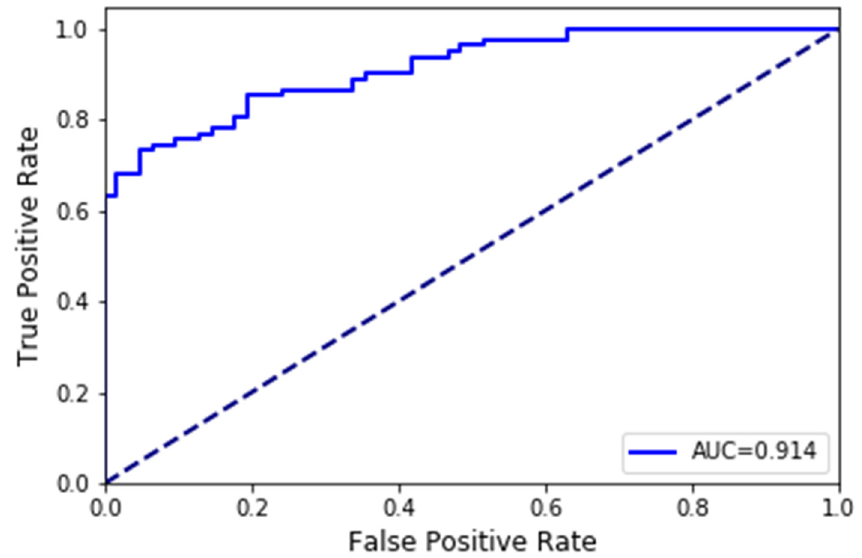
Figure 14. The ROC of RF.